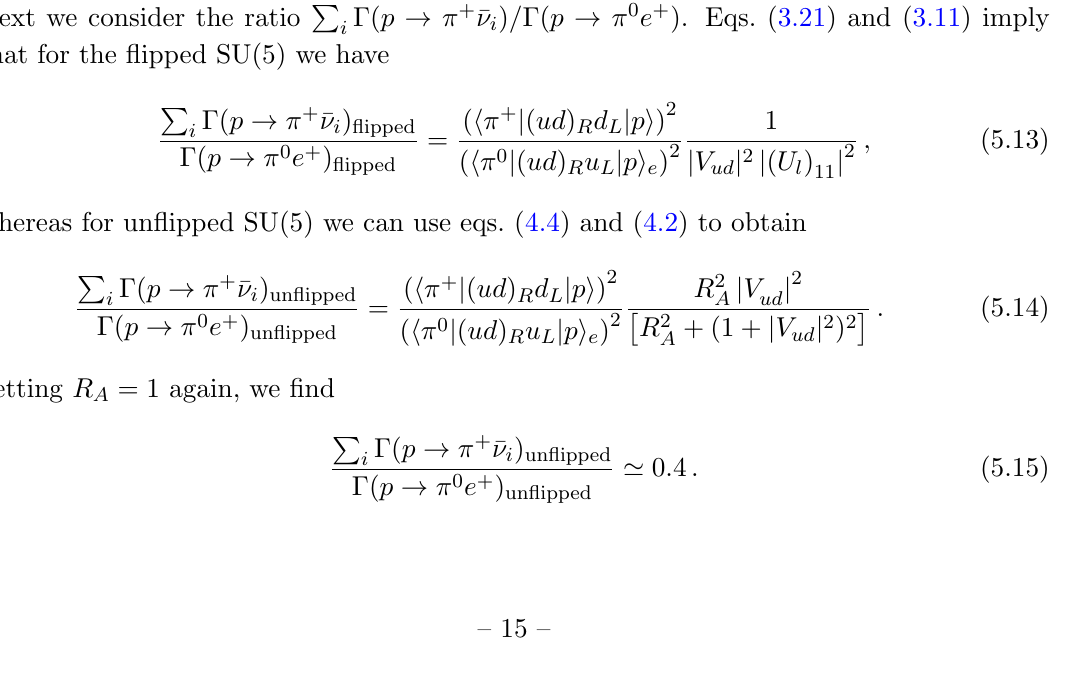
Figure 2 . Scatter plots of values of (cid:0)( p for the NO and IO cases (blue and green, respectively), as functions of the lightest neutrino